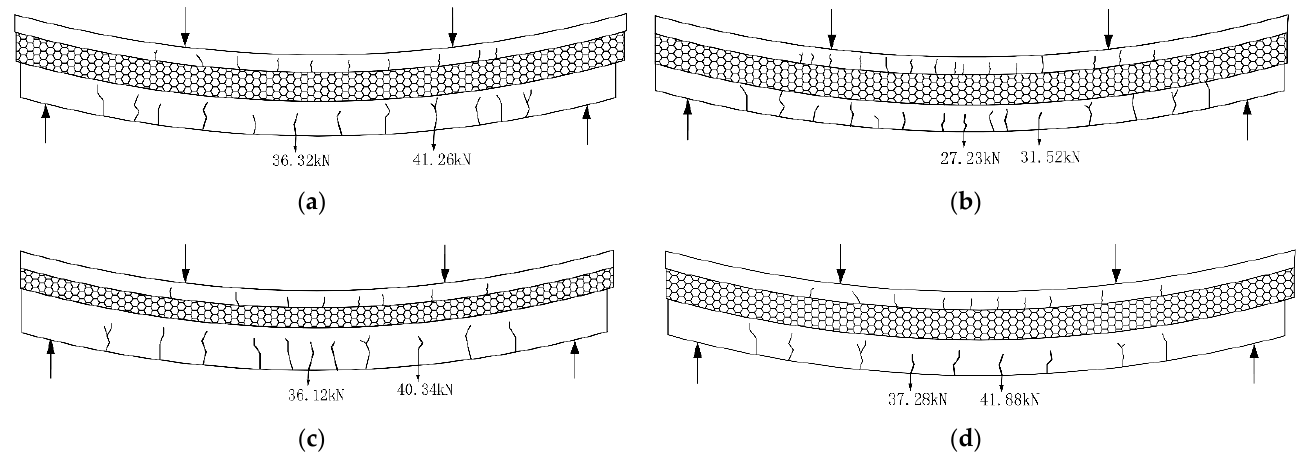
Figure 6. Specimen deformation and crack distribution (The arrow indicates the direction of force):